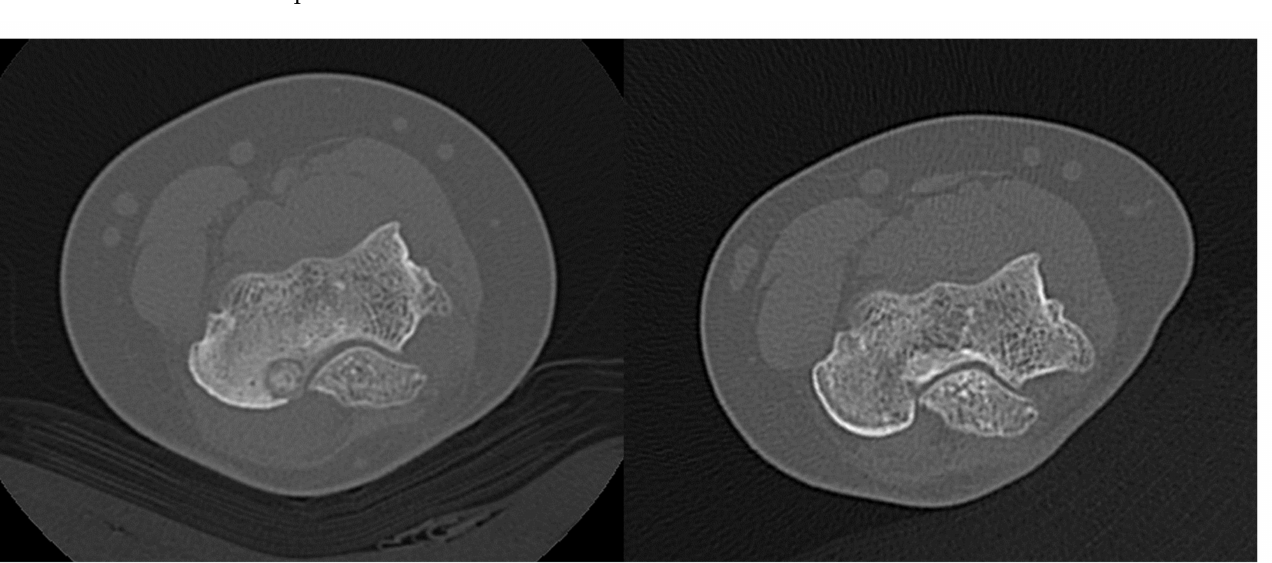
Figure 6. AnOBoftheelbowina16year-oldgirltreatedsuccessfullywithMRgFUS.Acompleterestitution ad integrum with normal trabecular bone restoration was observed (follow-up time: 22